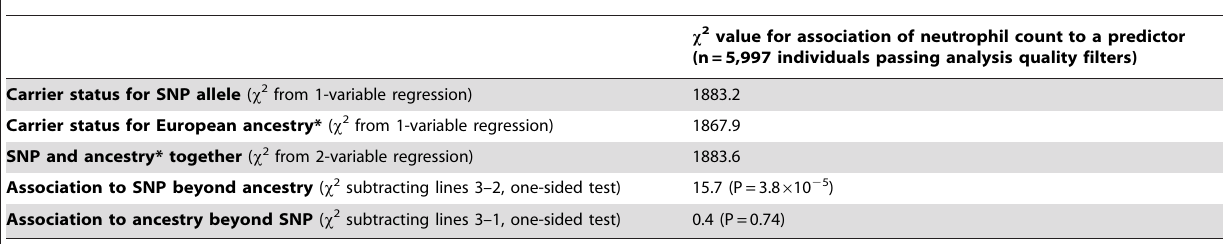
Table 4. Reduced neutrophil count is more associated to the Duffy null polymorphism than to ancestry.